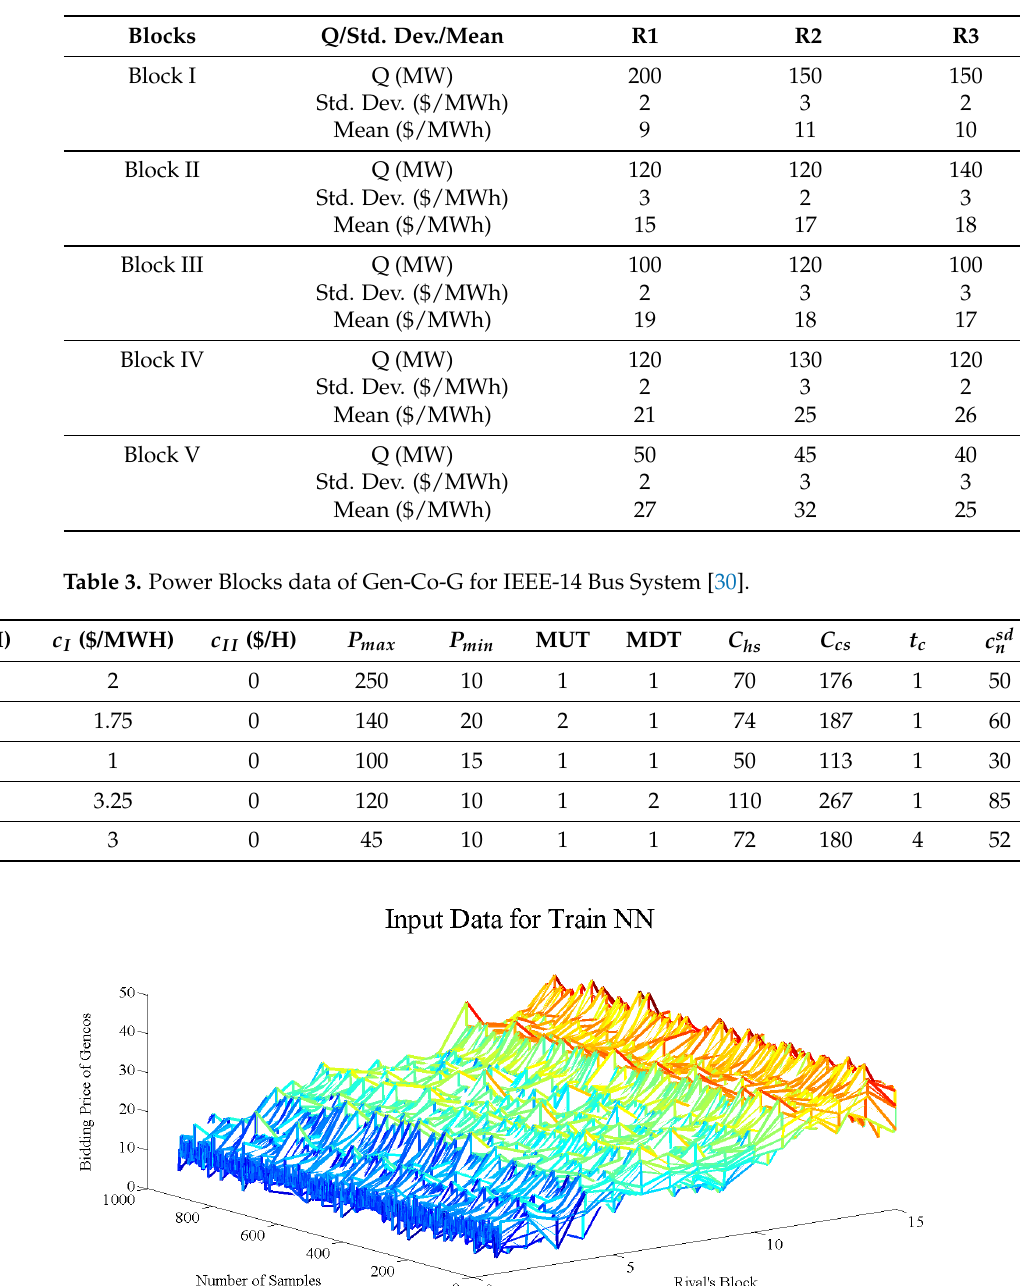
Table 2. Rival’s Bidding Data for IEEE-14 Bus System [30].